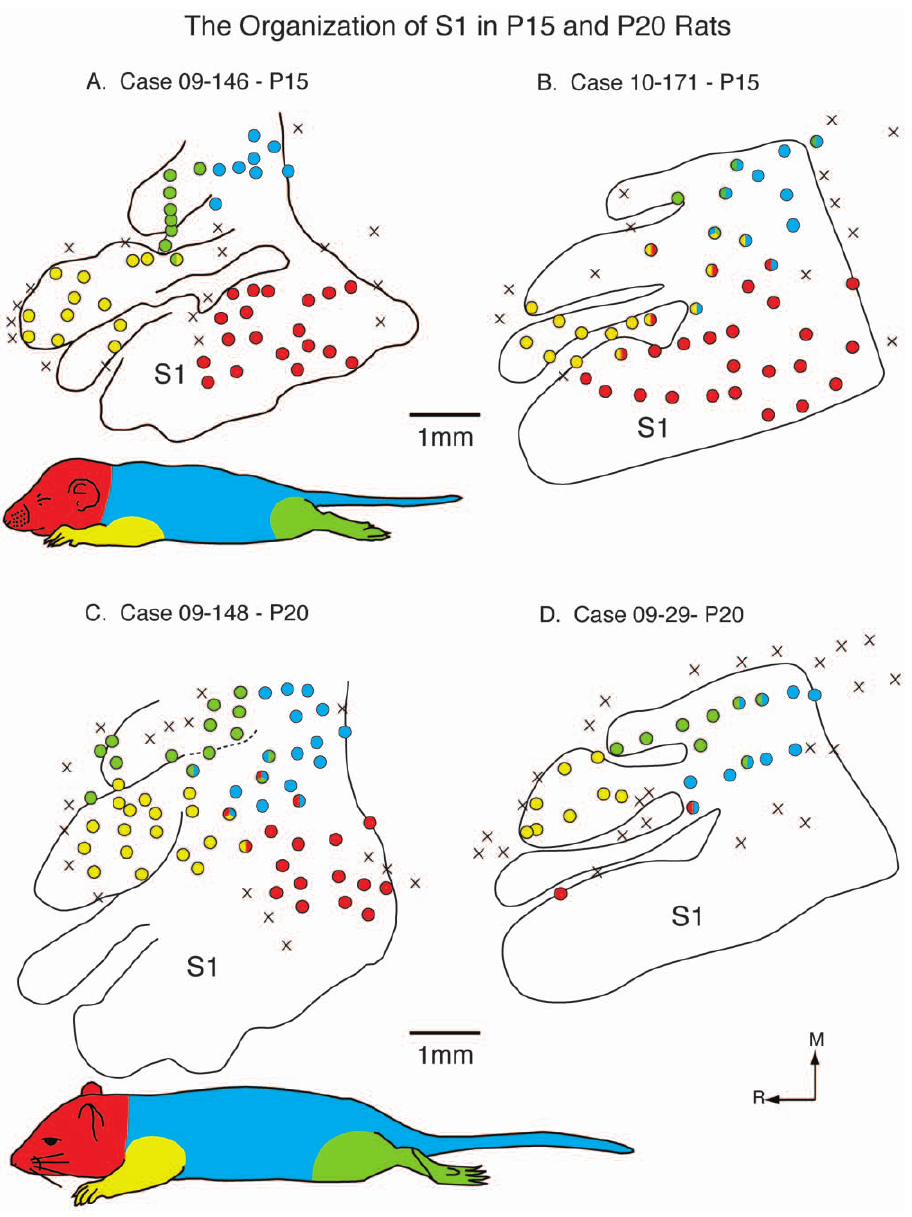
Figure 9. Functional S1 maps in P15 and P20 rats. Reconstructed functional maps of primary somatosensory cortex in P15 (A and B) and P20 (C and D) rats. At P15, normal somatotopy is beginning to emerge, but there is still considerable variability in map organization between individuals (compare A and B). By P20, the functional maps have an adult-like organization. Conventions as in previous figures.